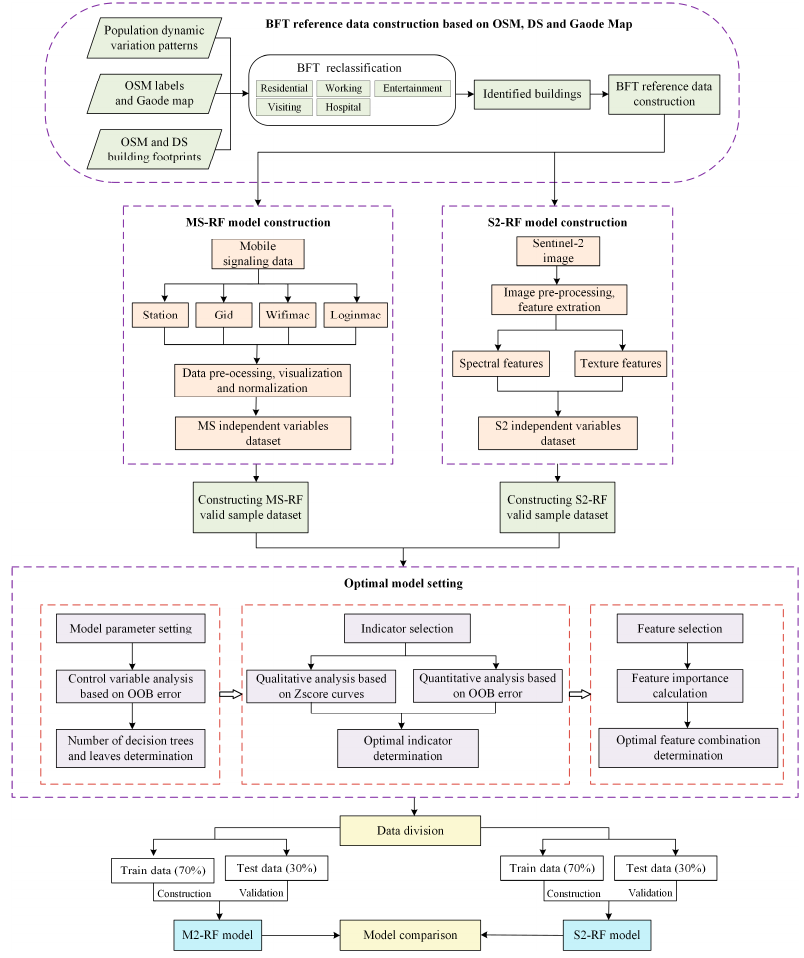
Figure 8. Construction process of the MS-RF and S2-RF models.